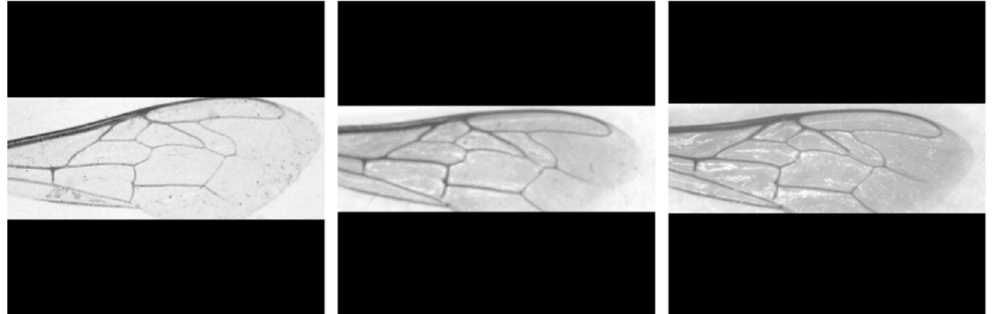
Figure 10. Examples of mounted images presented to the U-Net input.